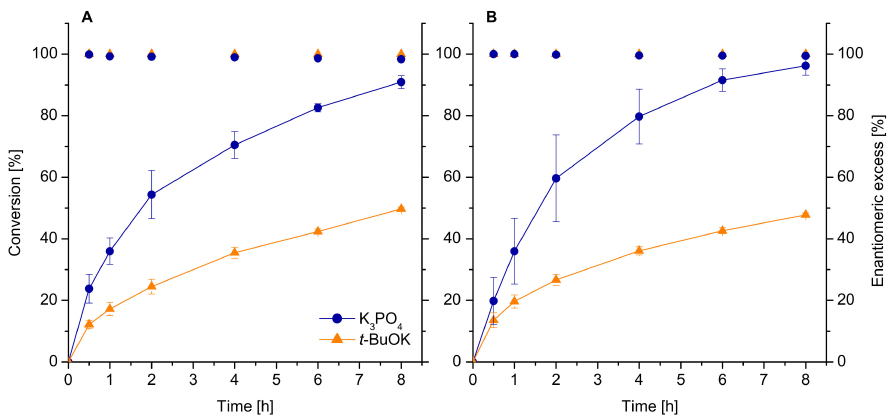
Figure 3. Conversion and enantiomeric excess of the ( R )-1-phenylethyl acetate vs. time in the dynamic kinetic resolution of ( rac )-1-phenylethanol catalyzed by CALB-MCF-3.0Me and ruthenium complexes: 1 ( A ) and 2 ( B ), using two activators (K 3 PO 4 and t